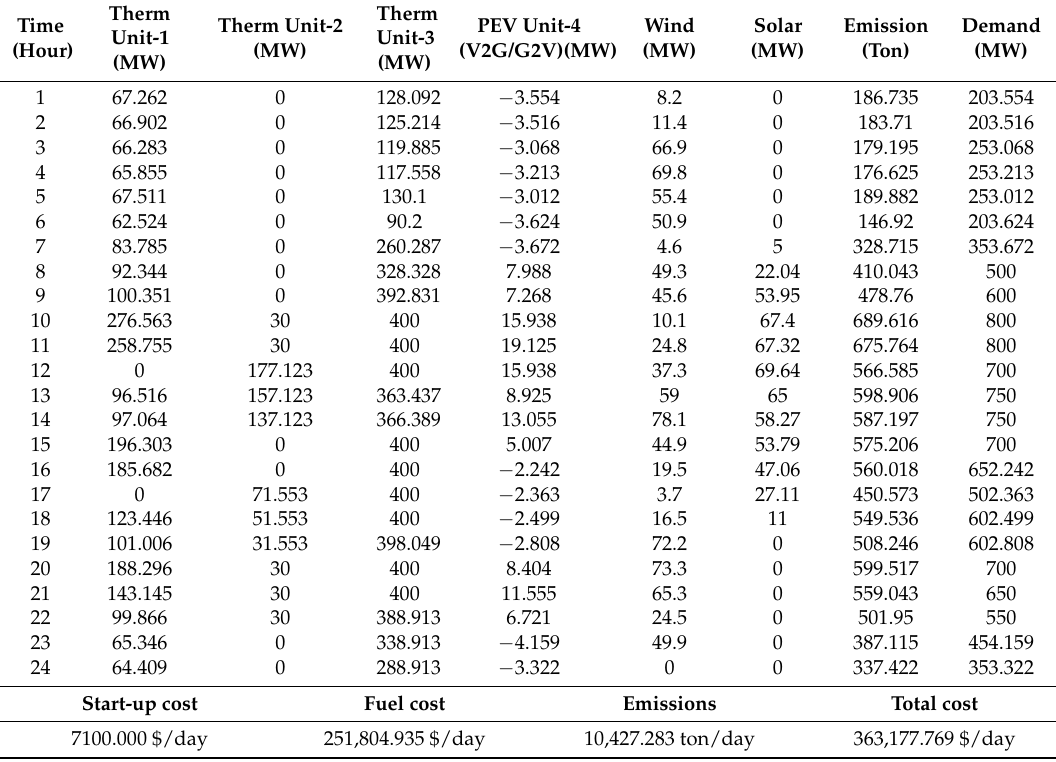
Table 8. Integration PEVs with RESs (wind-solar) with base three thermal generating units’ simulation results by the WCOA.